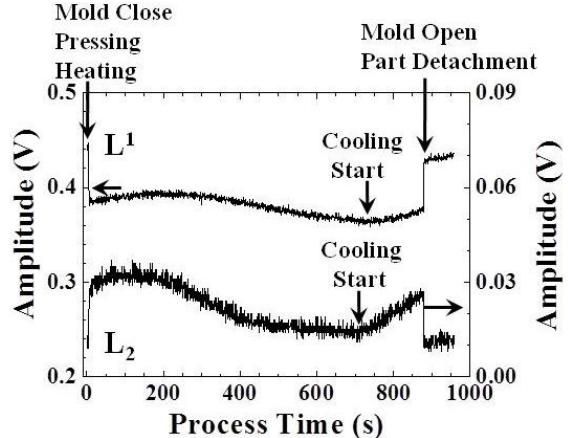
Figure 8. Amplitude variations of the ultrasonic L 1 and L setting of 100  C, indicating the mold closure, pressing, heating, cooling and mold opening during the embossing